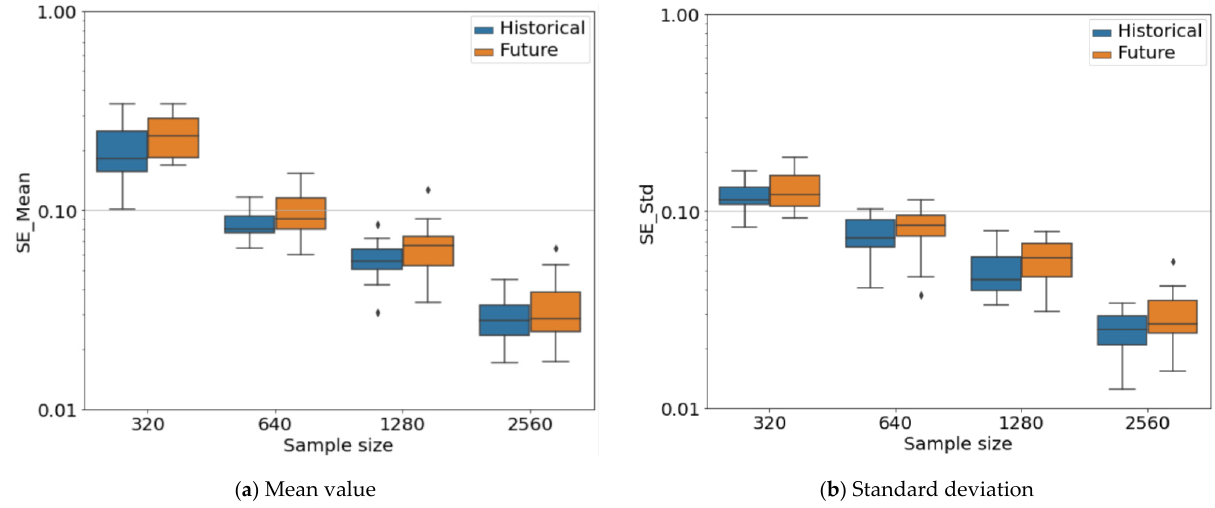
Figure 12. Convergence rate for different climatic realisations. Note: there are 15 climatic realisations, therefore, the sample